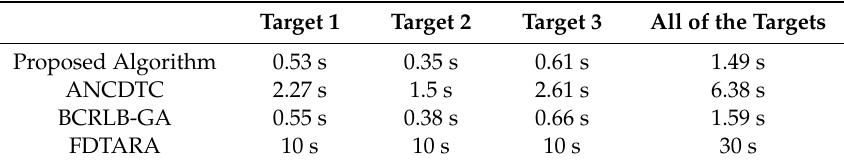
Table 3. Comparison of total dwell time of radar network.